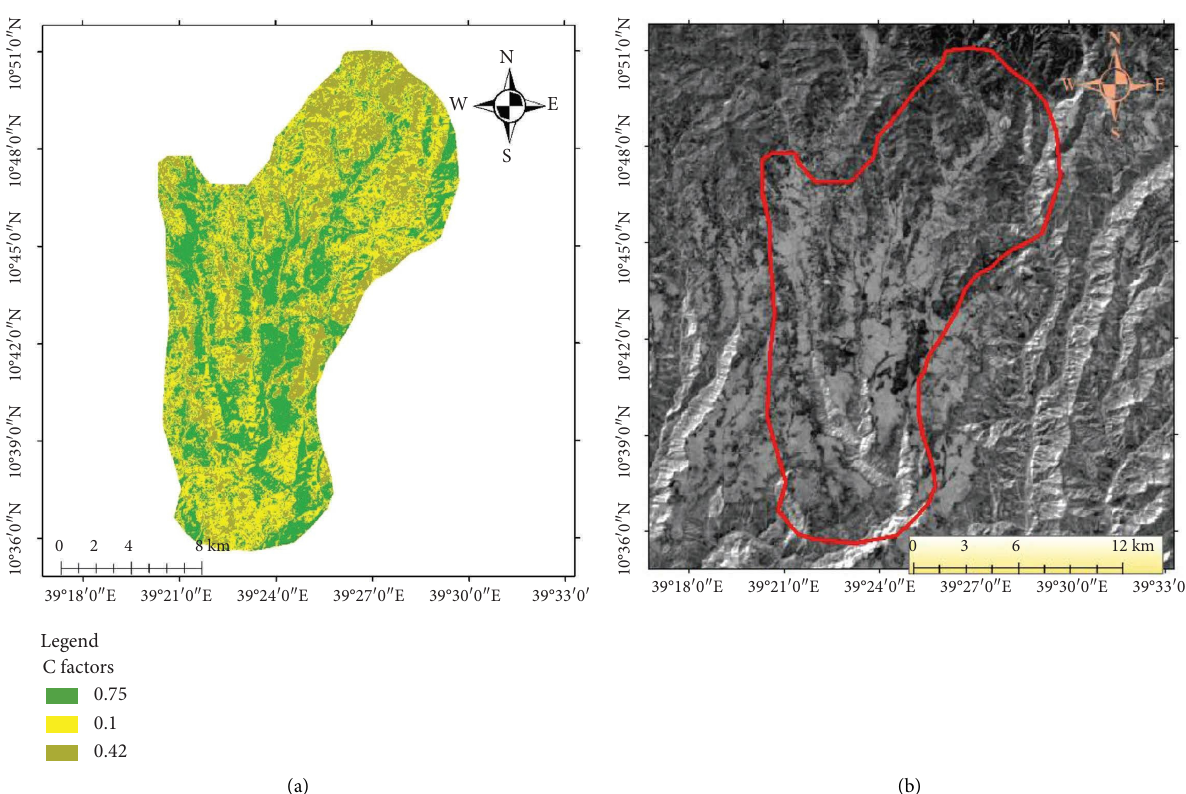
Figure 5: Crop management ( C -factor) map of the study watershed (a) and Landsat image of the study watershed (b).